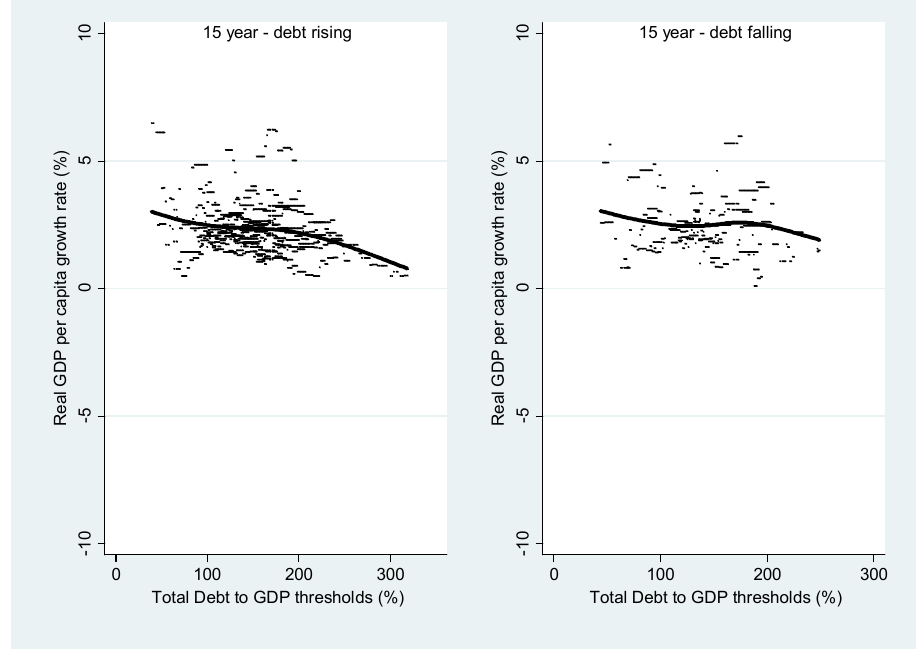
Figure 8 - Debt trajectory and long-term economic